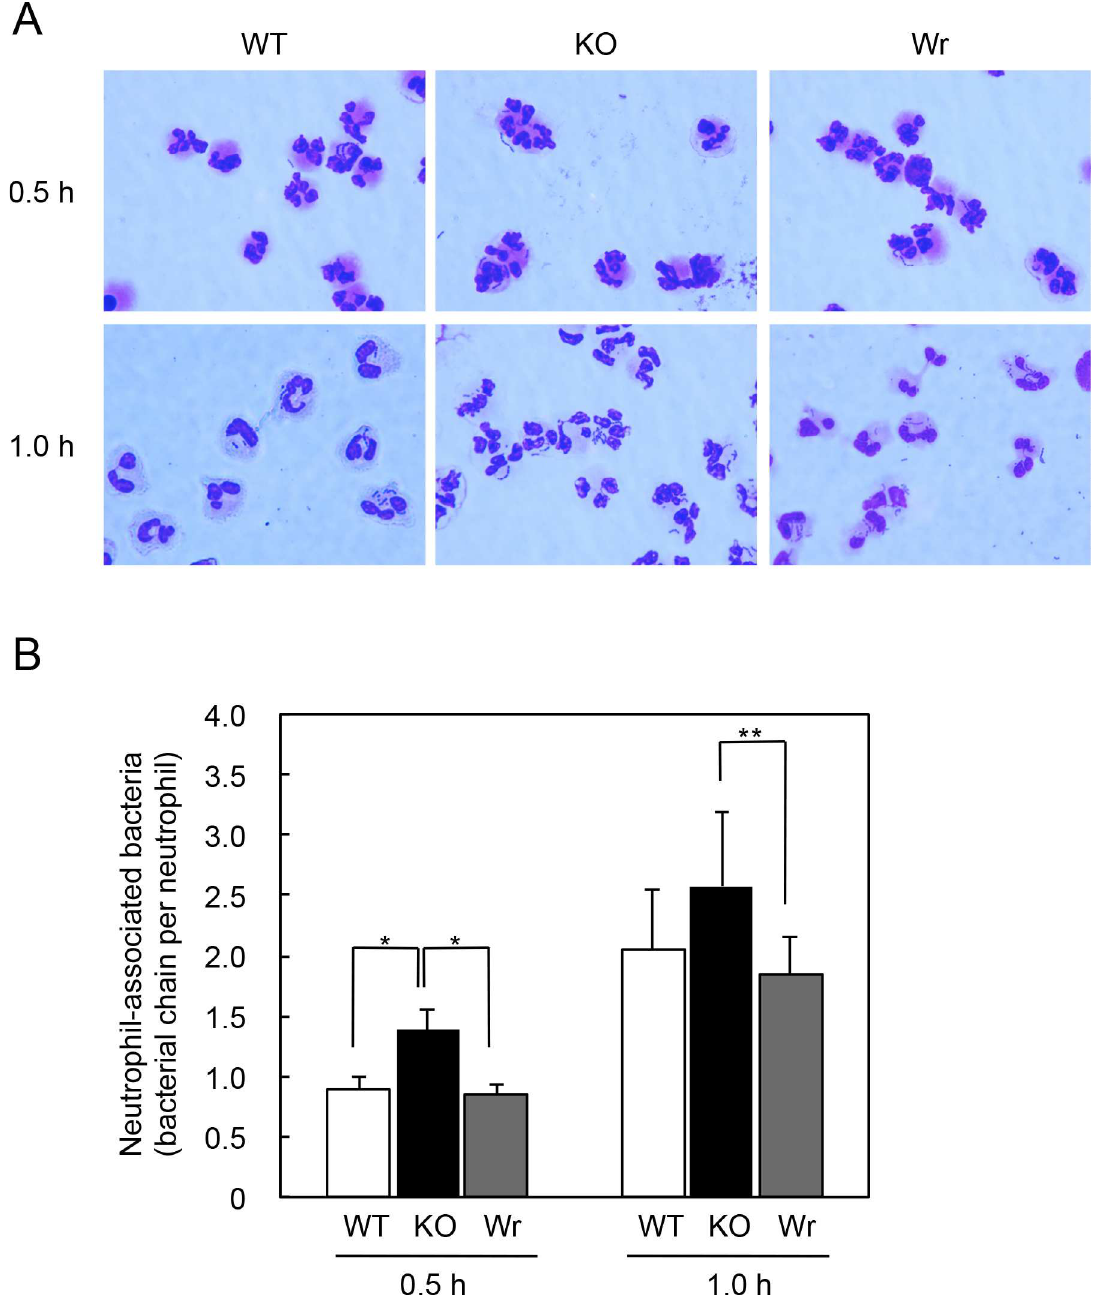
Fig 3. Bacterial association with human neutrophils. Human neutrophilswere pre-incubated for 30 min, then infected with the WT, KO, or Wr strain at an MOI of 10. Followingincubation for 0.5 or 1 h, cells were fixed with methanoland visualizedby Giemsa staining.Using phase-contrast microscopy, 10 random fields (x 1000) were observedand the amount of bacteria demonstrating phagocytosisby neutrophilswas determined by countingbacterialchains. (A) Representative images. (B) The numbers of bacterial chains associatedwith neutrophilsat 0.5 and 1 h after infection are shown as the mean ± SD of 5 independent experiments. Statistically significantdifferenceswere evaluatedusing one-wayANOVA and Tukey’s multiple comparison test. * p < 0.01, ** p <